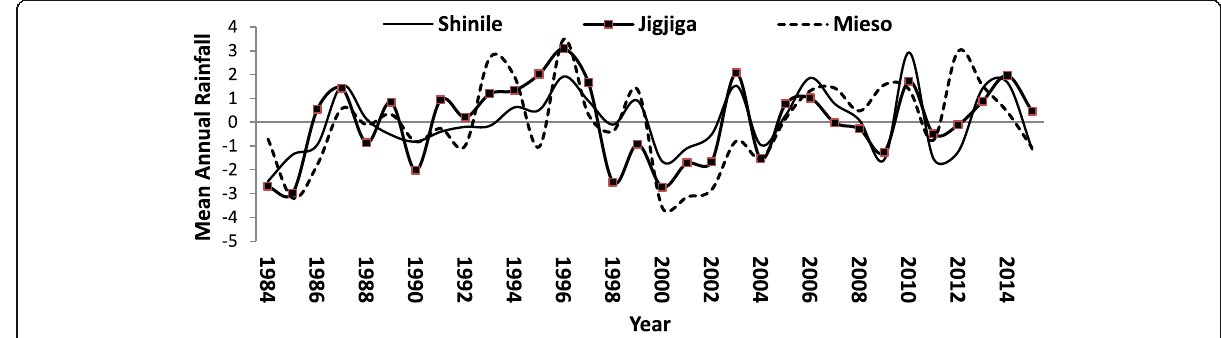
Fig. 2 Mean annual standardized rainfall anomalies and trend for Mieso, Jigjiga, and Shinile districts over the period of 1984 – 2015